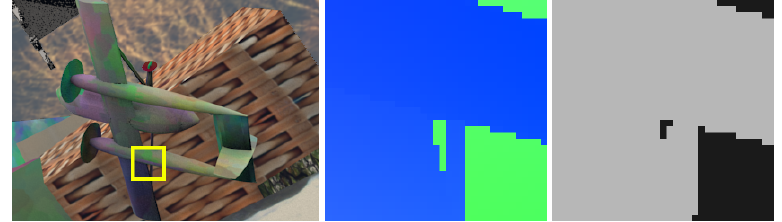
Figure 5. Sample from FlyingThings3D dataset with a cutout of its corresponding ground truth optical flow and object segmentation. Notice how the transition from the airplane to the background object happens at different positions in the two